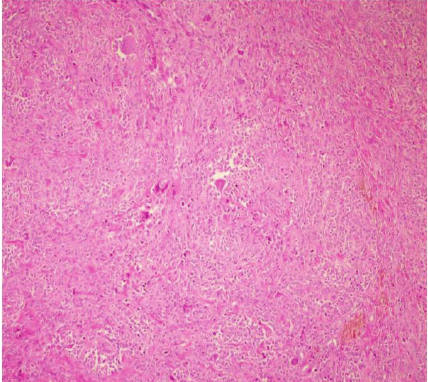
Figure 3: Multinucleated giant cells scattered on the floor contain- ing collagenous stroma and round mononuclear cells (H.E. ×